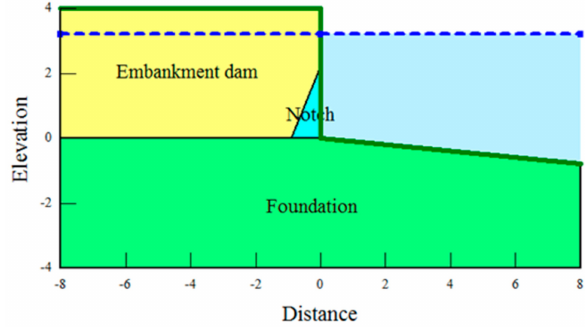
Figure 7. Definitions and simplification of the geometry of an embankment, an eroded notch and a foundation with SLOPE / W (2012, GEOSLOPE International Ltd., Calgary, AB, Canada).